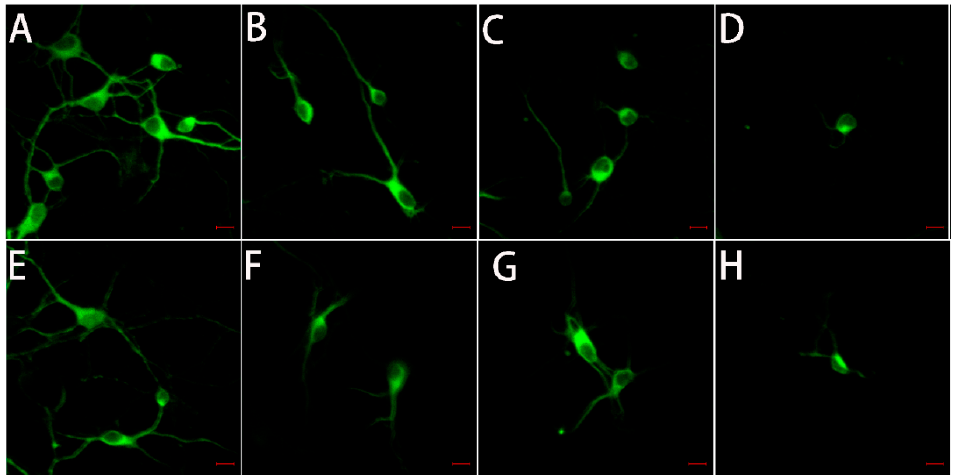
Figure 7. Typical confocal images of primary neurons treated with tau-R3 aggregates, Zn 2+ , or Zn 2+ -tau-R3 aggregates at 37 °C for 12 h. The final concentrations of tau-R3 and Zn 2+ were 7.5 μ M and 3.5 µ M. ( A – D ) Hippocampal neuron, ( E – H ) cortical neuron, ( A , E ) the control group, ( B , F ) tau-R3 treated neurons, ( C , G ) Zn 2+ treated neurons, ( D , H ) Zn 2+ -tau-R3 treated neurons. The scale bars represent 10 µ m.